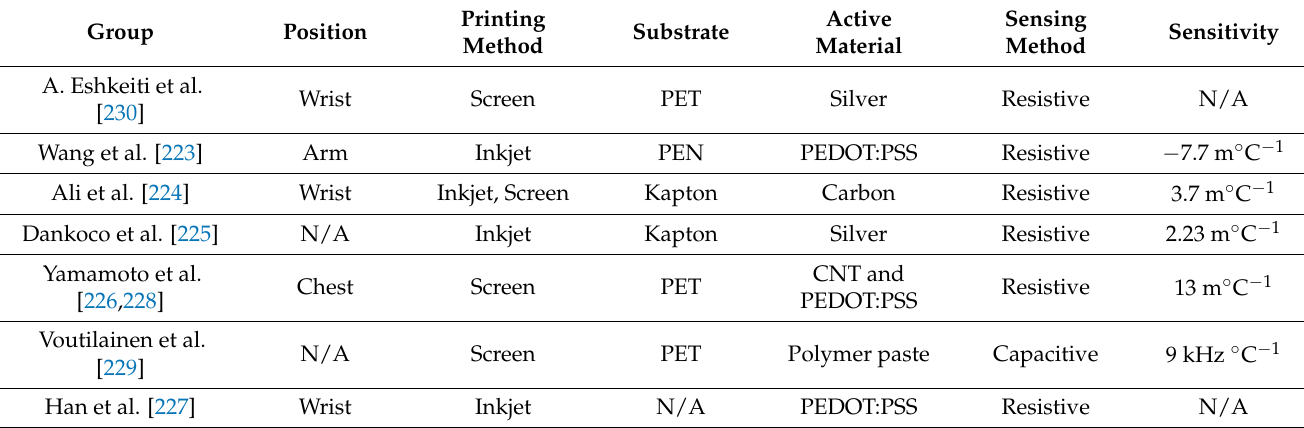
Table 2. Comparison between selected printed temperature